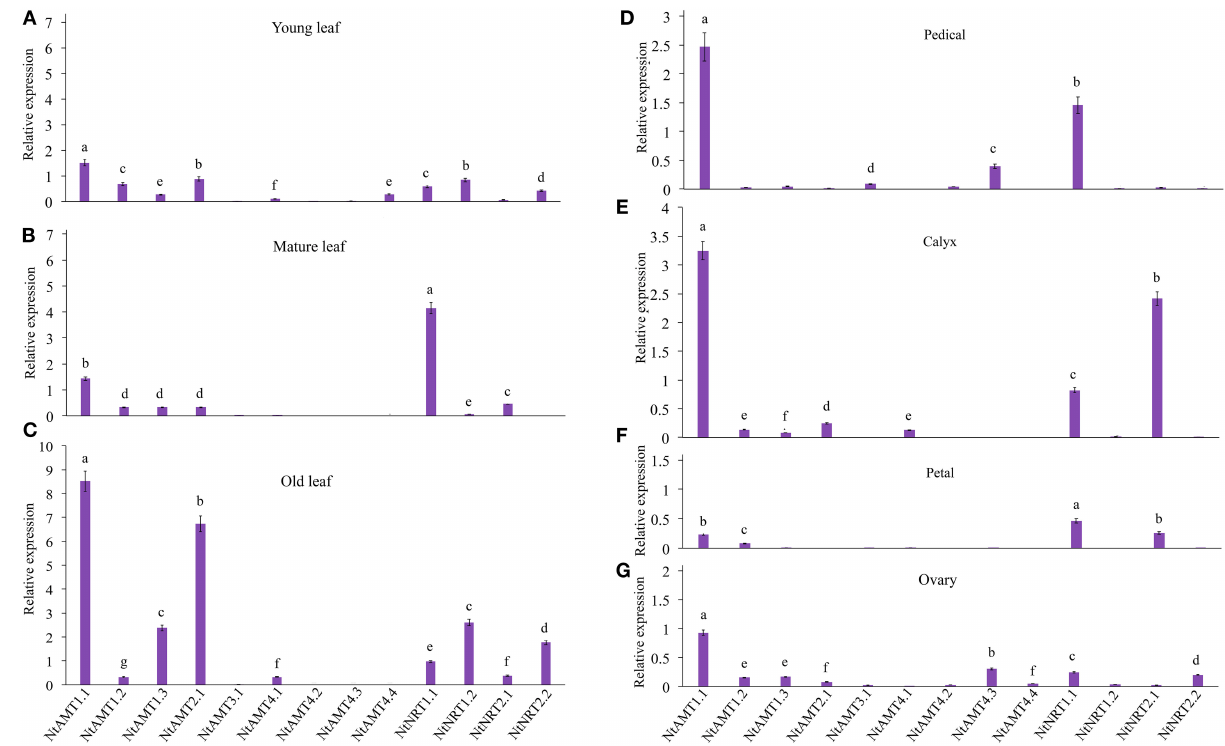
Frontiers in Plant Science |